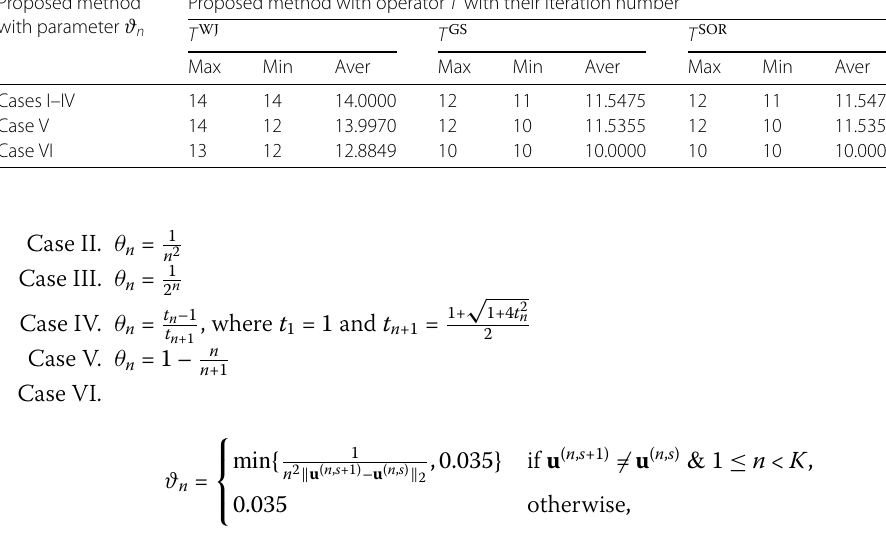
Table 4 The maximum, minimum, and average number of iterations per time step for the proposed algorithm Proposed method with parameter ϑ